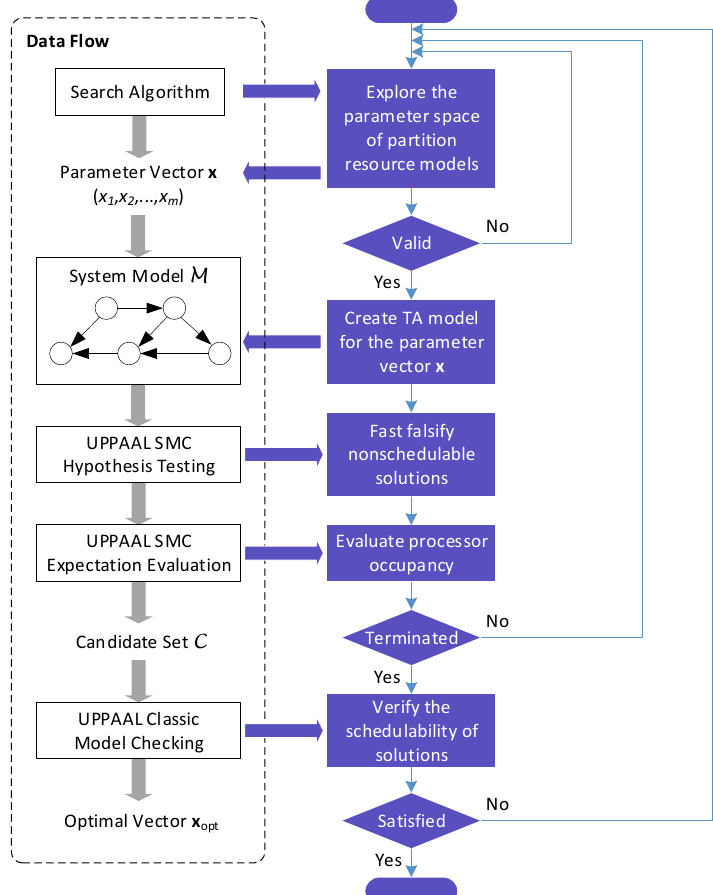
Figure 2. Flowchart of model-based optimization